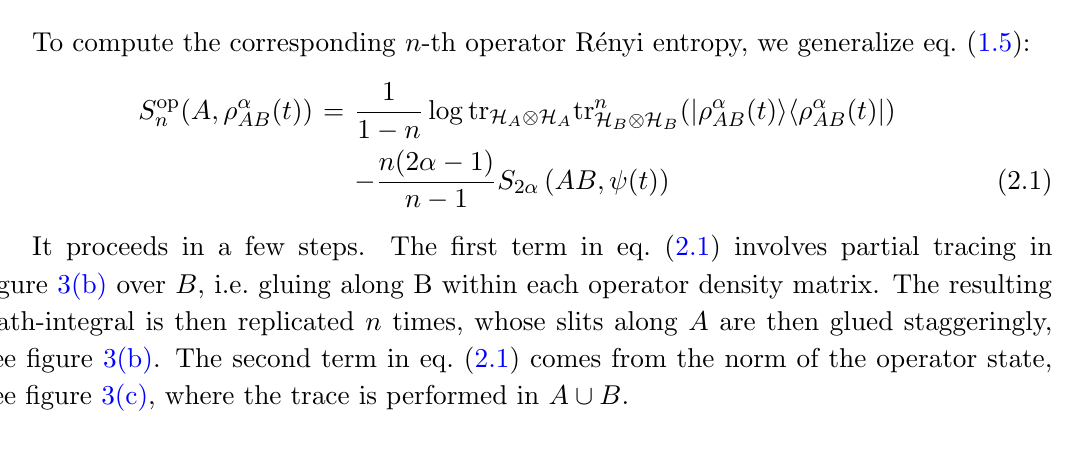
Figure 3 . The Euclidean path integrals for evaluating the operator R(cid:19)enyi entropy,the two intervals represent A and B respectively. (a): the operator state matrix (cid:26) (cid:11) (cid:26) (cid:11) (right). (b): the non-trivial part of the operator R(cid:19)enyi entropy, where the way AB ih AB j j to connects layers is di(cid:11)erent in A and B. (c): the normalization of the operator density matrix, which is mapped to the state R(cid:19)enyi entropy. (d)/(e): the corresponding twist (cid:12)eld insertion for